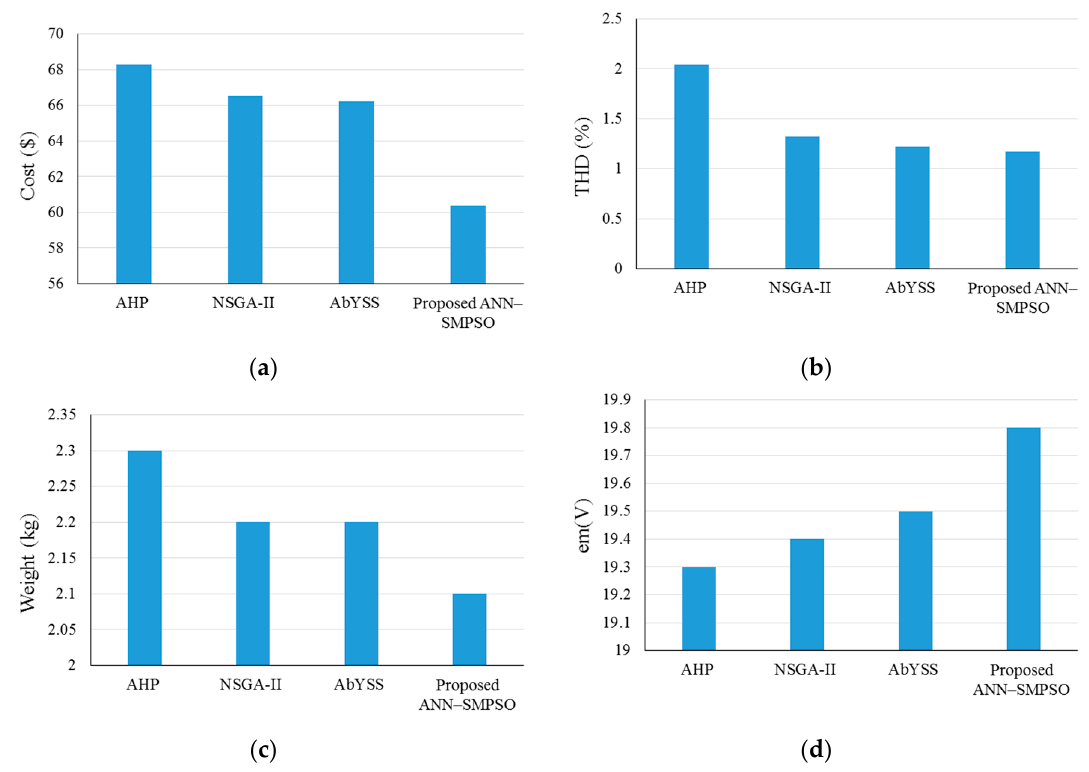
Figure 17. Results for the study by Meo et al. (2016) [100] in terms of ( a ) cost; ( b ) THD; ( c ) weight and ( d ) em.